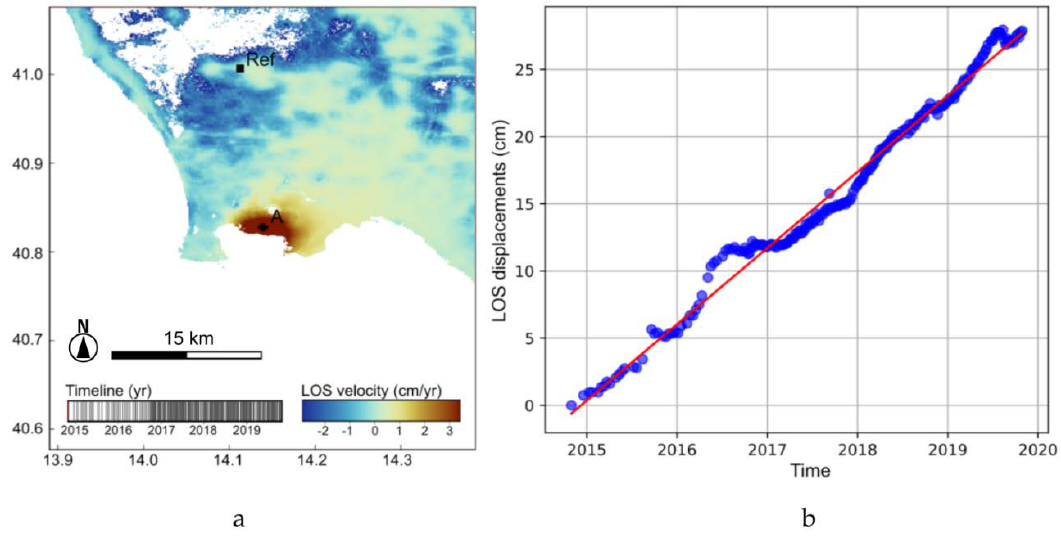
Figure 14. LiCSBAS InSAR time series derived from LiCSAR products showing ( a ) the LOS velocity map generated for the Campi Flegrei area (frame ID 022D_04826_121209) and ( b ) the displacement time-series for point A, centered on the caldera, with respect to the reference area located ~20 km north of the caldera.